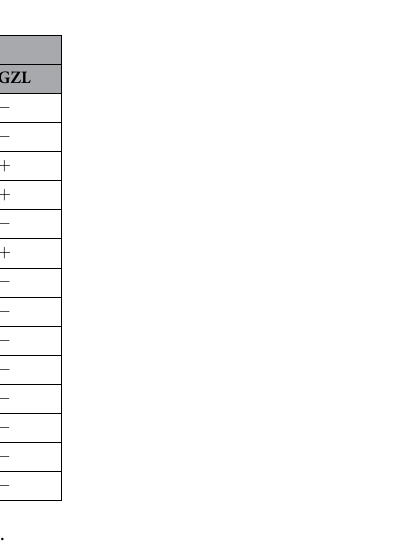
Table 2. The types and of potential pathogens in all